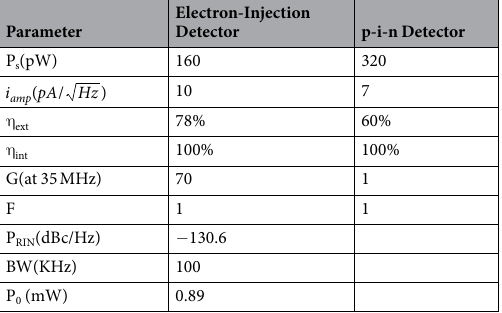
Table 1. Key parameters defining the system SNR performance.